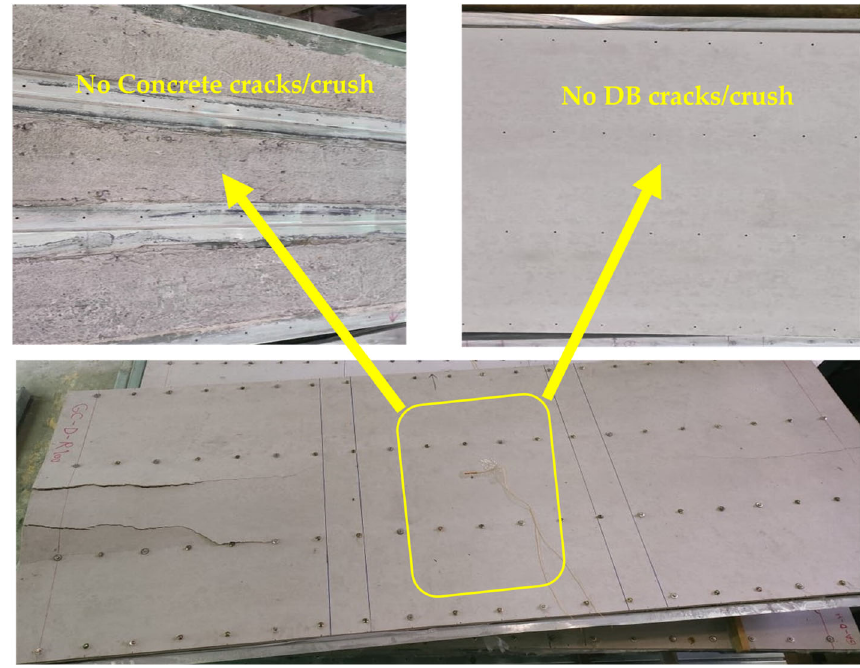
Materials 2023 , 16 , x FOR PEER REVIEW Figure 9. Bending behavior of the CBPDS in mid-span for all specimens. Figure 9. Bending behavior of the CBPDS in mid-span for all specimens.